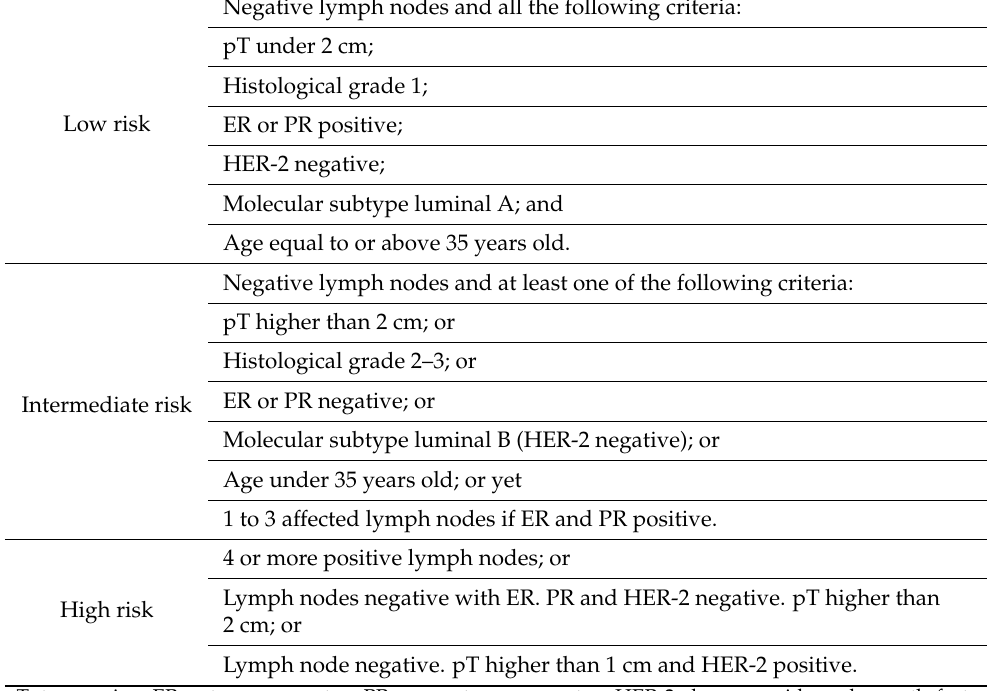
Table 1. Criteria for risk stratification of recurrence and death of patients diagnosed with breast cancer (based on Goldhirsch et al.